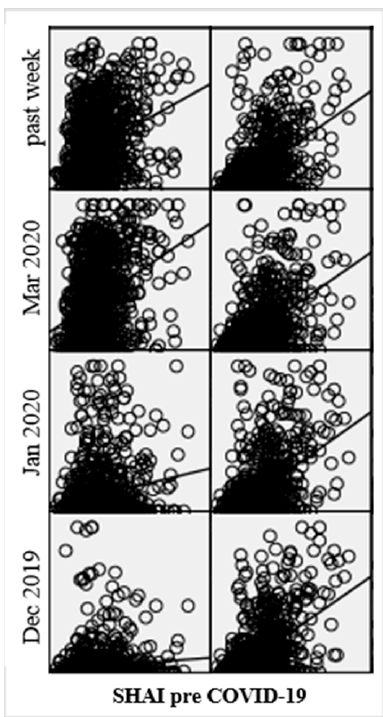
Figure 2. Anxiety in relation to SARS-CoV-2 (including COVID-19) (left) and in relation to other severe diseases (not COVID-19; e.g., cancer) (right) as a function of health anxiety (SHAI) pre COVID-19 over the course of the COVID-19 pandemic (December [Dec] 2019, January [Jan] 2020, and March [Mar] 2020, retrospectively